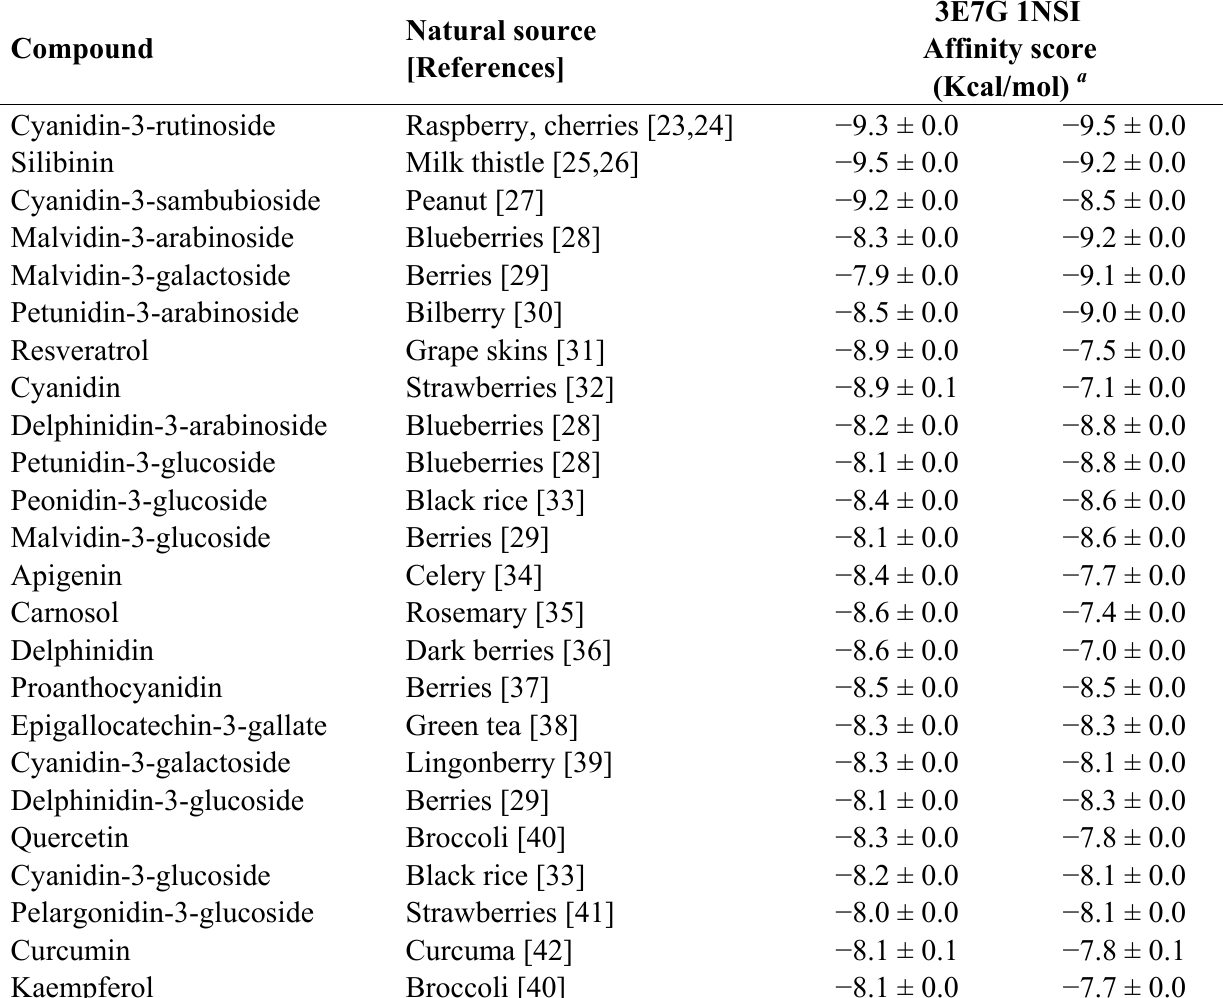
Table 1. AutoDock Vina-calculated affinities obtained for docking of natural bioactive compounds on